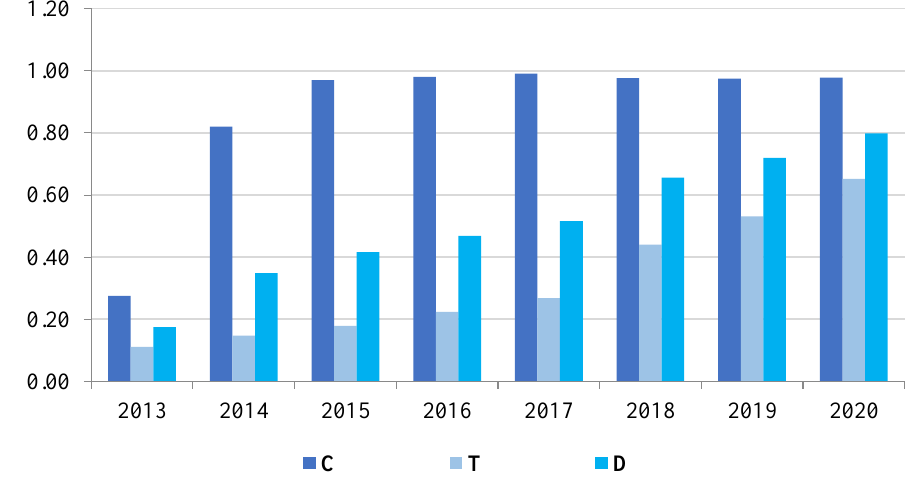
Figure 4. C, T, and D values of Anhui Province’s LI and DE.